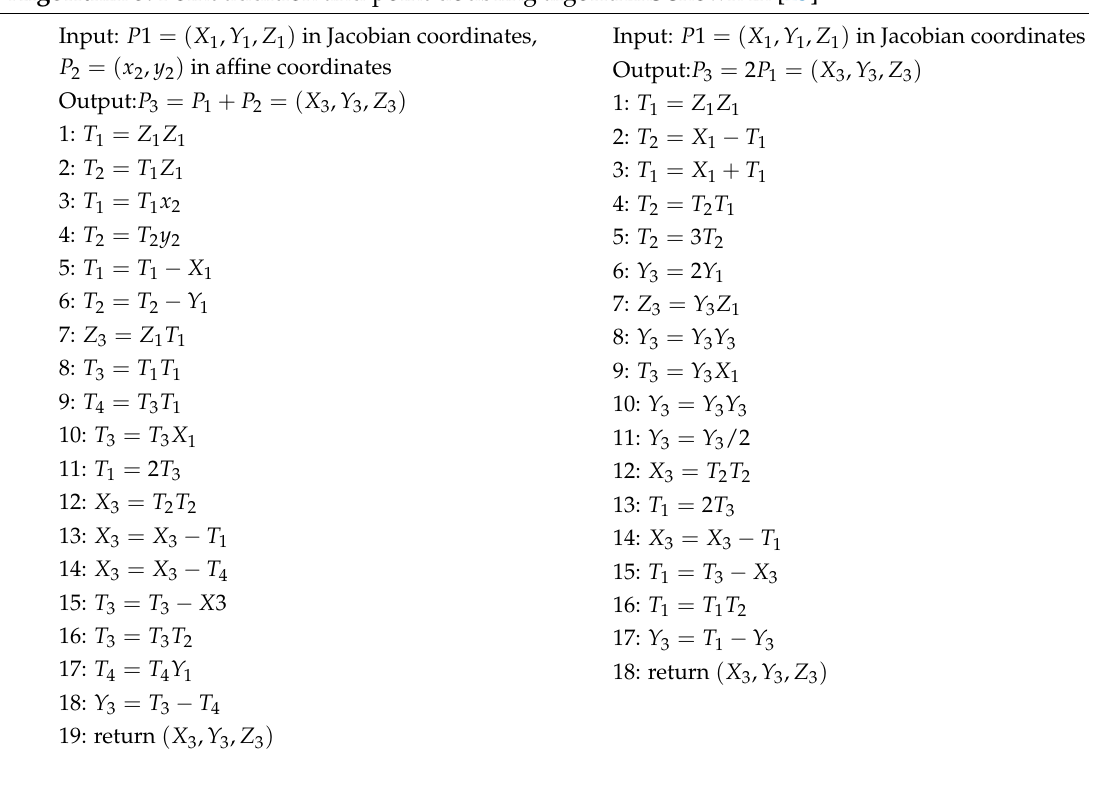
Algorithm 5: Point addition and point doubling algorithms shown in